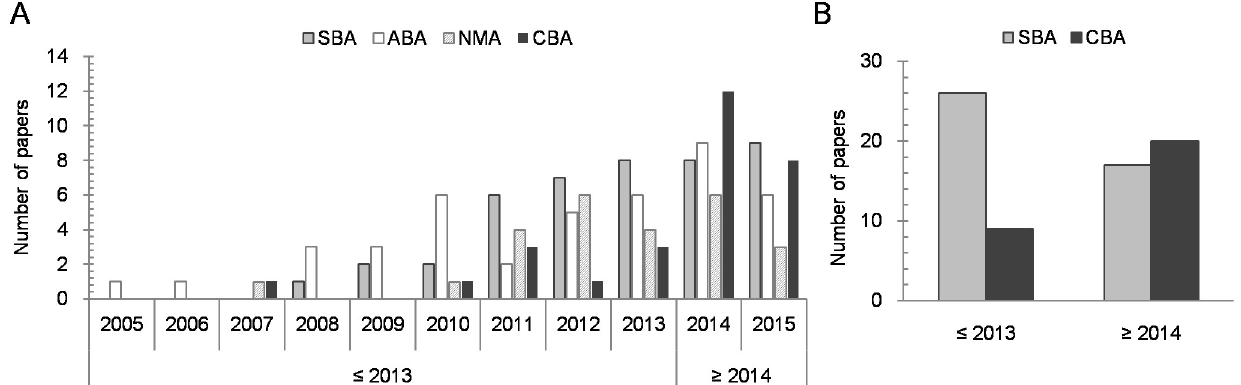
Fig 1. Number of studies published everyyear in each paper category (A), and number of studies published before and after 2014 in the SBA and CBA categories (B).